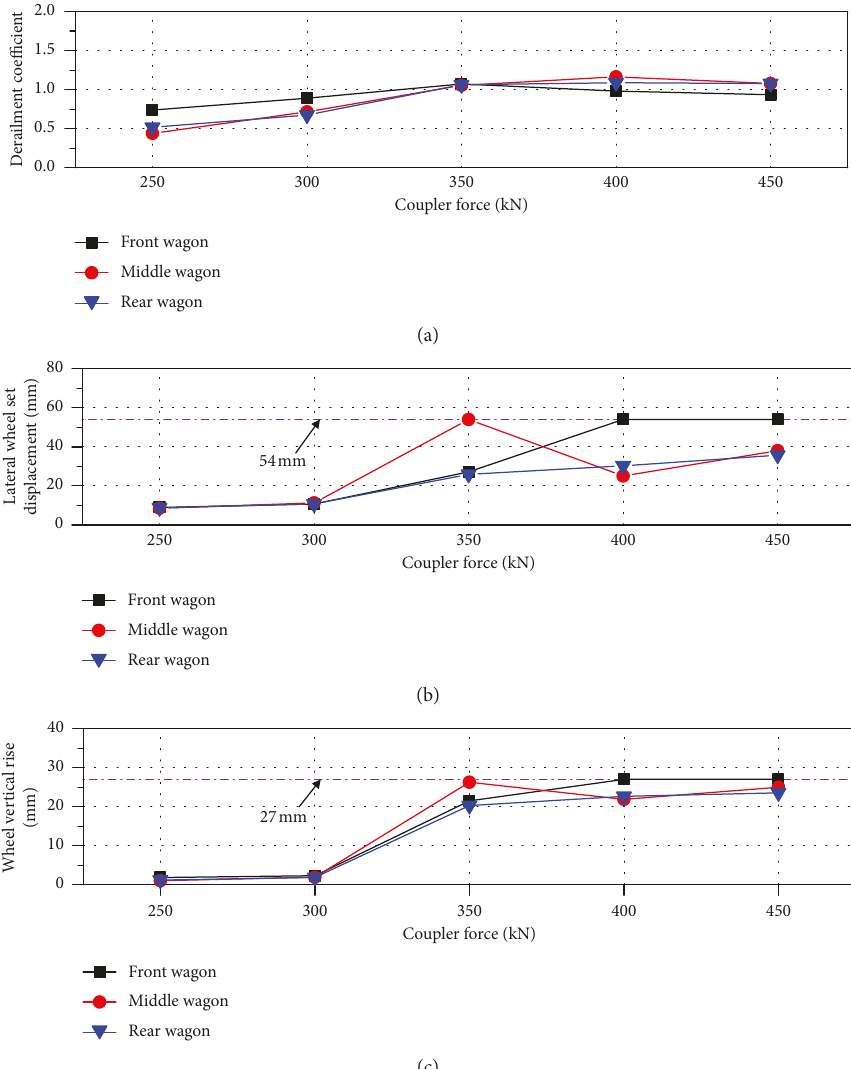
Figure 18: Effects of coupler force on (a) derailment coefficient, (b) lateral wheelset displacement, and (c) wheel vertical